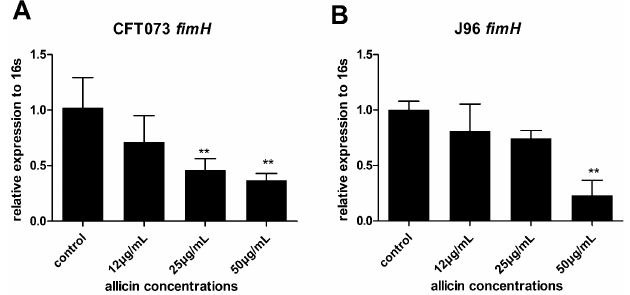
Figure 6. Relative transcript levels of UPEC CFT073 ( A ) and J96 ( B ) type 1 pili adhesin gene fimH were assessed by real-time quantitative polymerase chain reaction (RT-qPCR) with 16 s as an internal control relative to the untreated control set at 1. Bars indicate means ˘ SD of three independent experiments, ** p < 0.01.